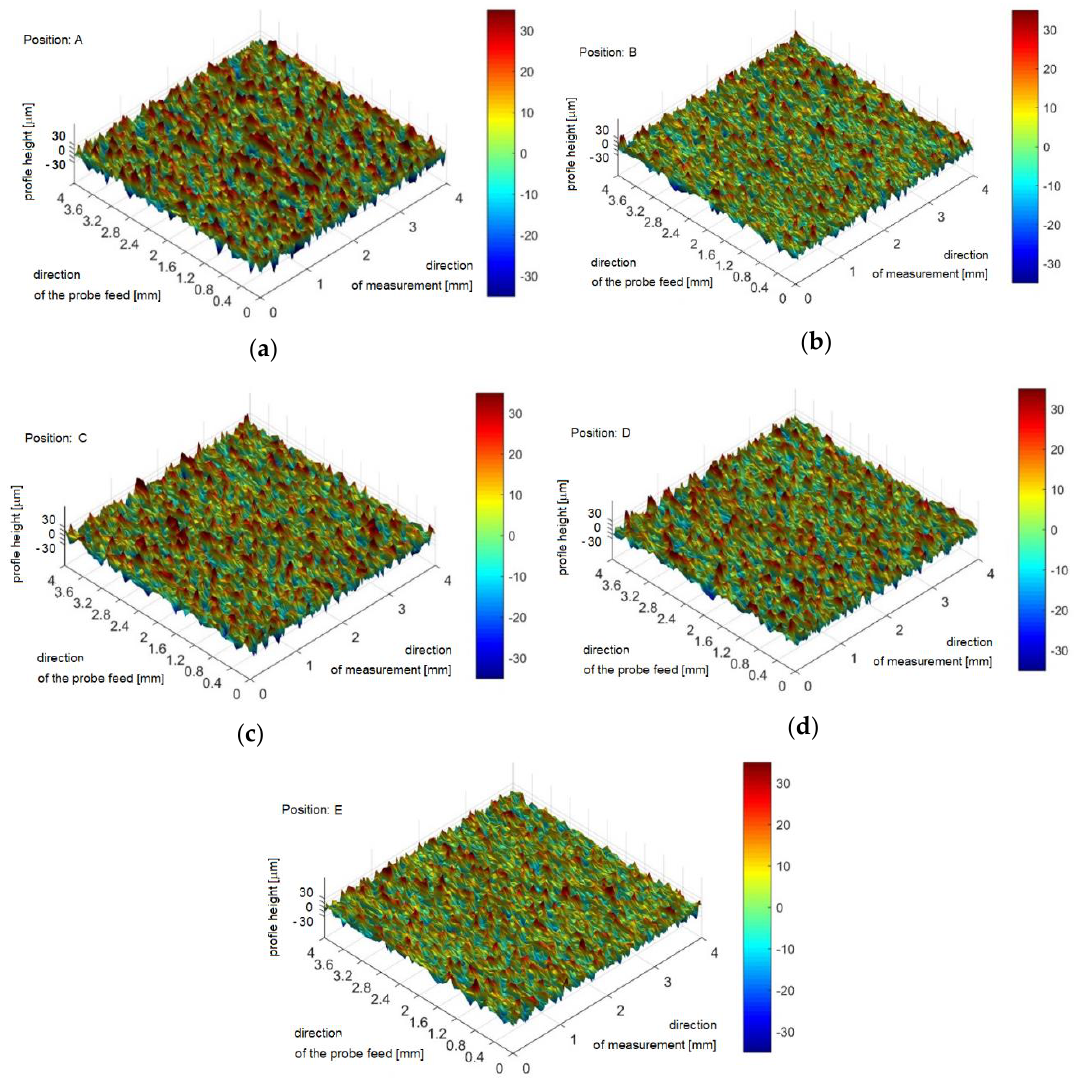
Figure 11. 3D maps of sample surfaces in individual positions: ( a ) position A, ( b ) position B, ( c ) position C, ( d ) position D, ( e ) position E.